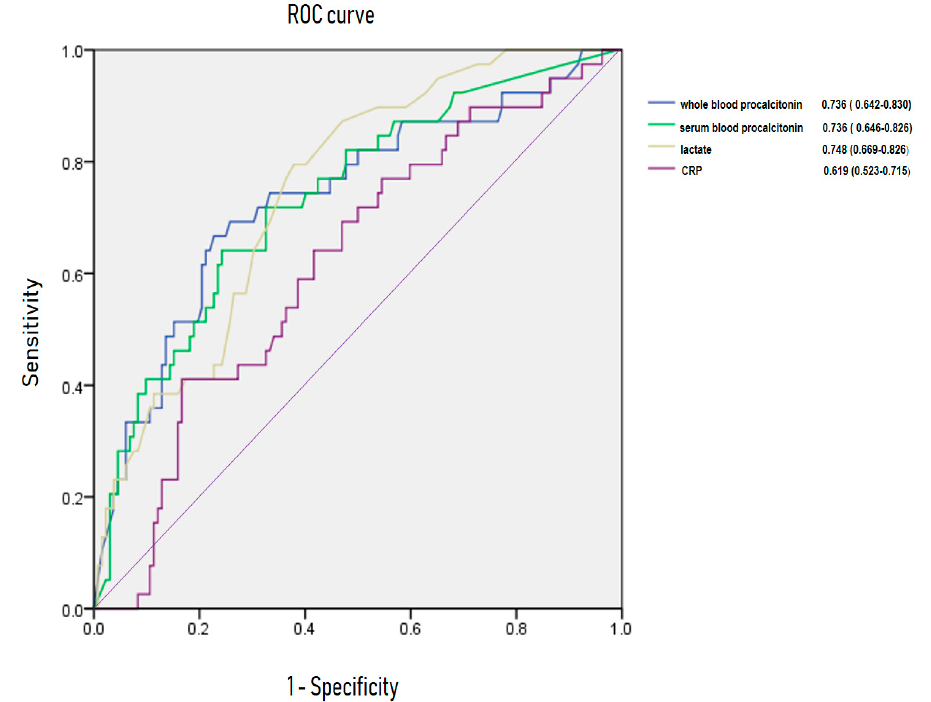
Figure 3. Area under receiving operating curve (AUROC) of C-reactive protein, lactate, procalcitonin 154 for predicting bacteremia 155